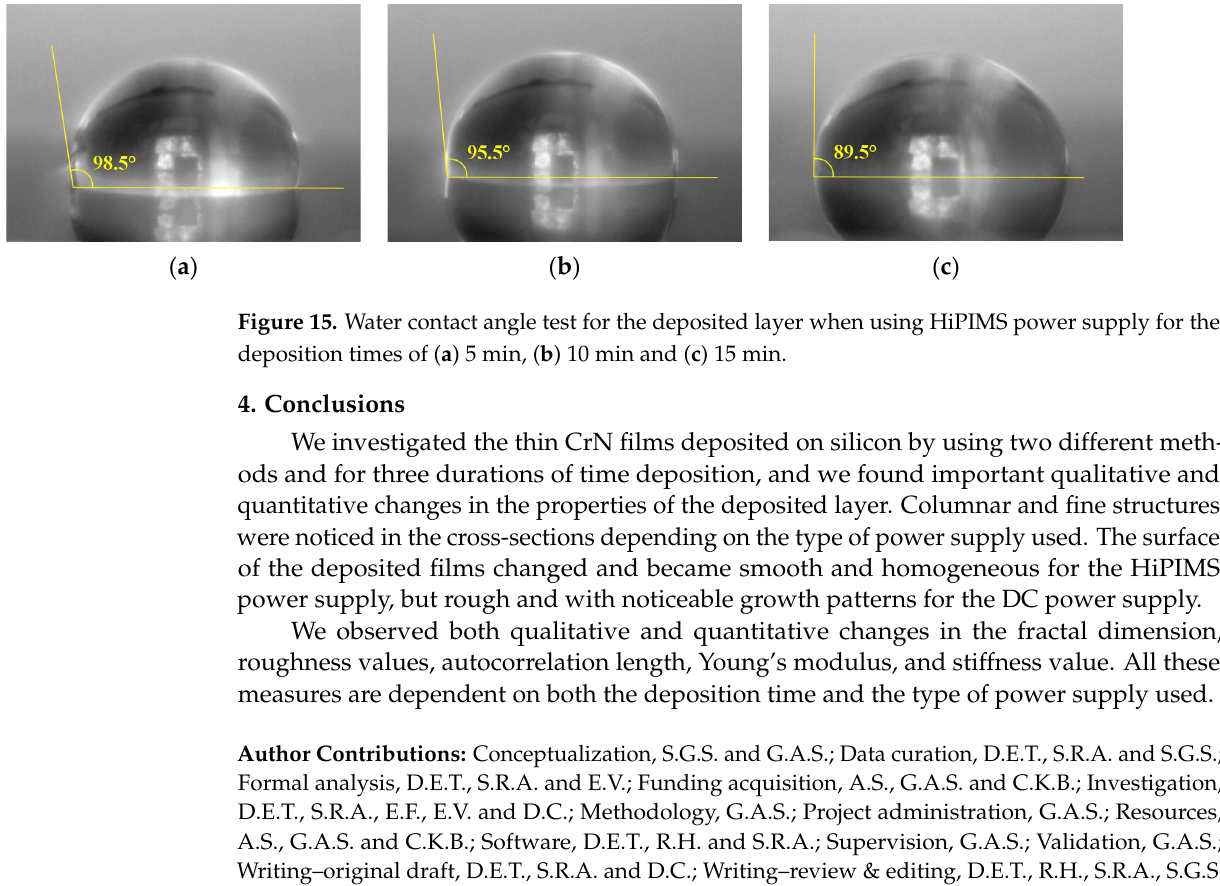
Figure 14. Water contact angle test for the deposited layer when using DC power supply for the deposition times of ( a ) 5 min, ( b ) 10 min and ( c ) 15 min.